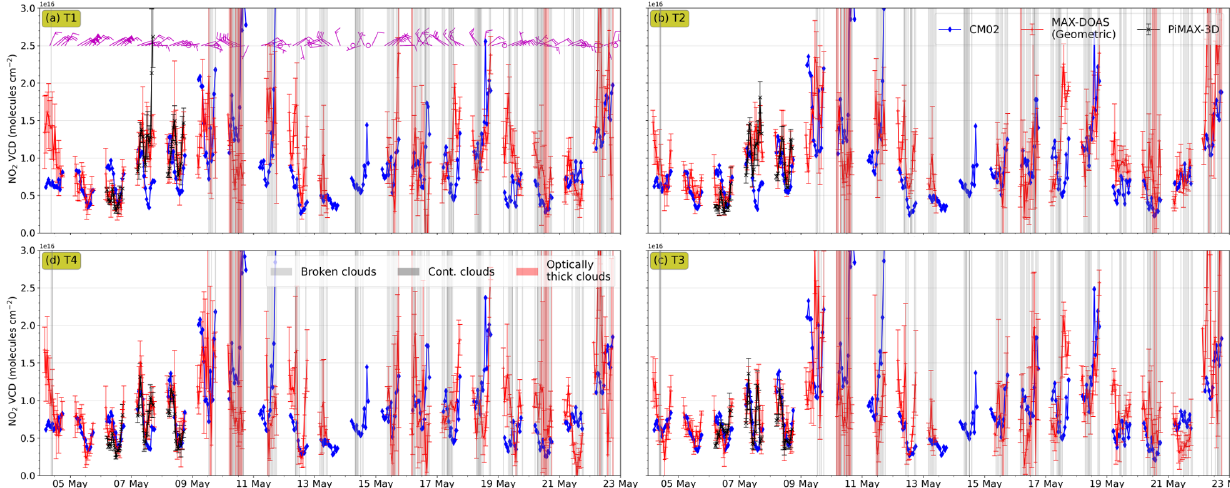
Figure 6. Comparison of NO 2 VCDs along the viewing directions of the four telescopes (T1–T4) simulated using the UBA di set-up in the CM02 domain. MAX-DOAS VCDs are retrieved using geometric approximation (red markers) for the complete measurement period and using π -MAX for 3d (black markers). The error bars represent the hourly 1 σ standard deviations. The shaded regions in the time series represent various categories of clouds as described in the legend. The purple barbs in panel (a) show the measured wind speed and wind directions, with half arrows, full arrows and flags corresponding to wind speeds of 1, 2 and 5m s − 1 ,